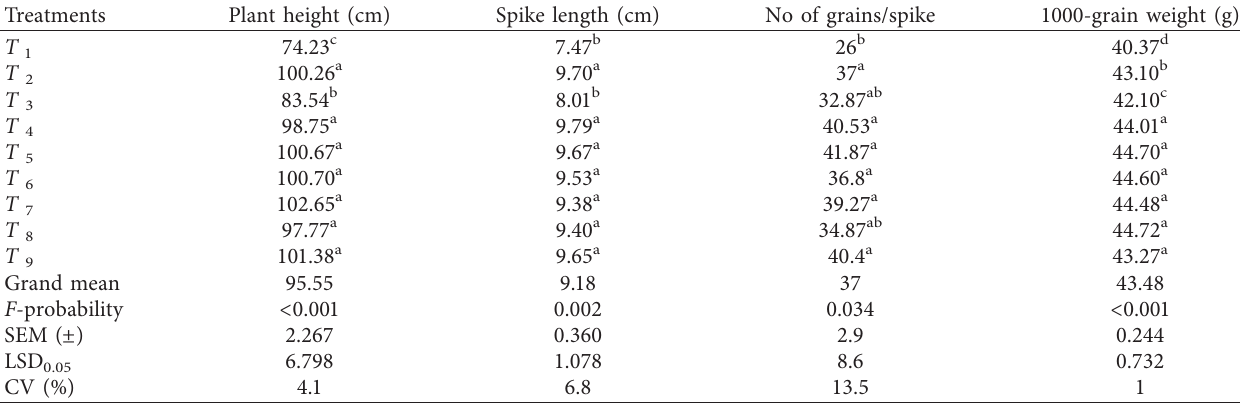
Table 4: Effect of chemical fertilizers and green manure treatments on the plant height, spike length, number of grains/spike, and 1000-grain